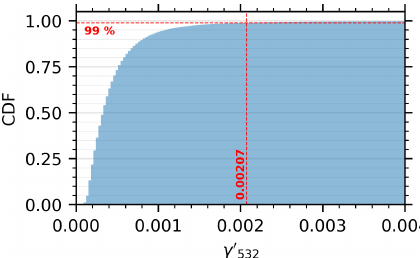
Figure A1. Cumulative distribution function of the integrated at- tenuated backscatter at 532nm of the uppermost layers detected at 80km horizontal averaging and with top altitude above 8km for the ≤ 0 . 00207 for 99% of these layers. year 2008. γ (cid:48) 532